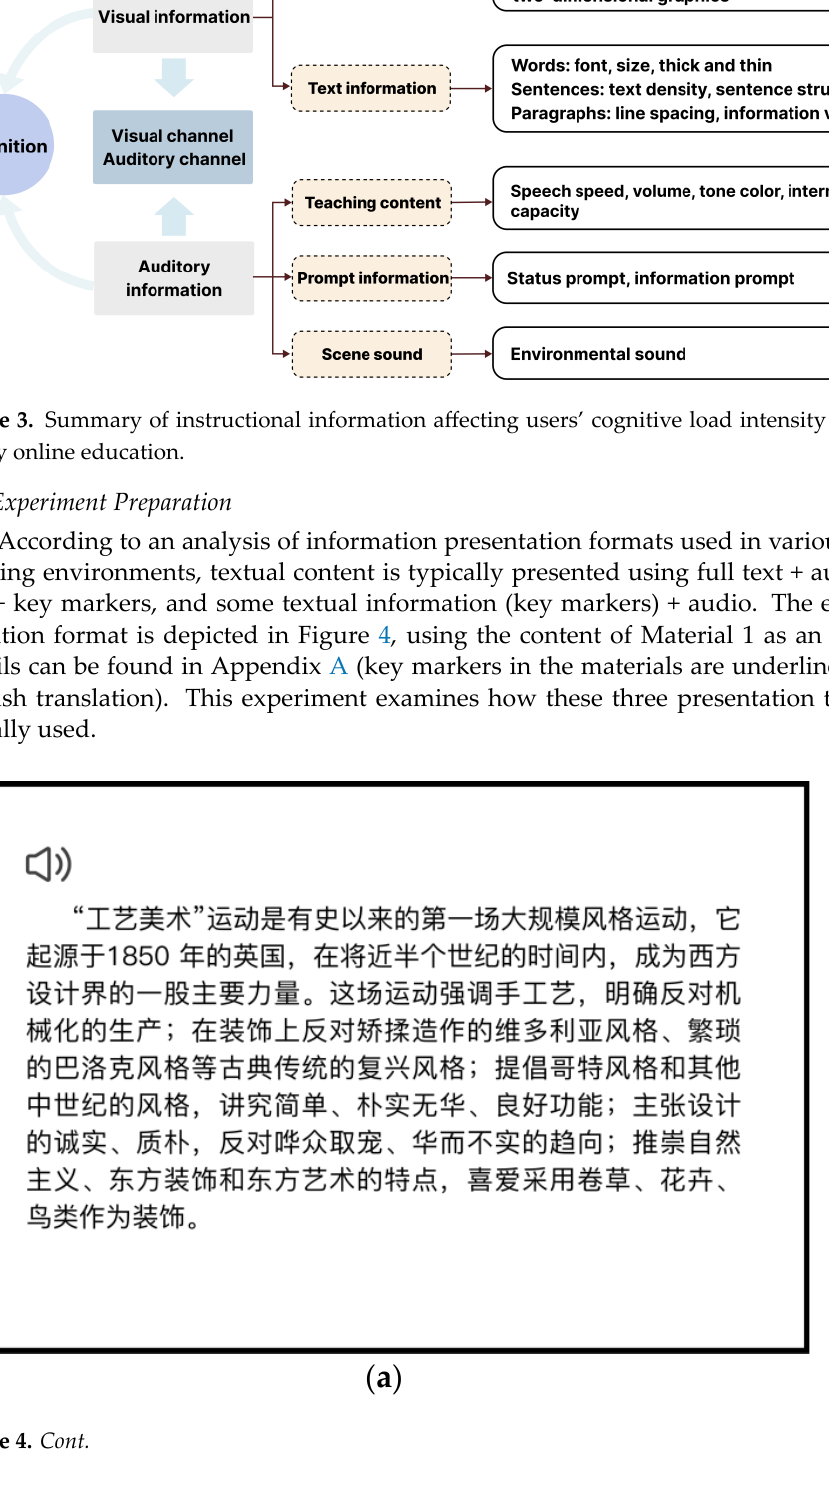
Figure 3. Summary of instructional information affecting users’ cognitive load intensity in virtual reality online education.